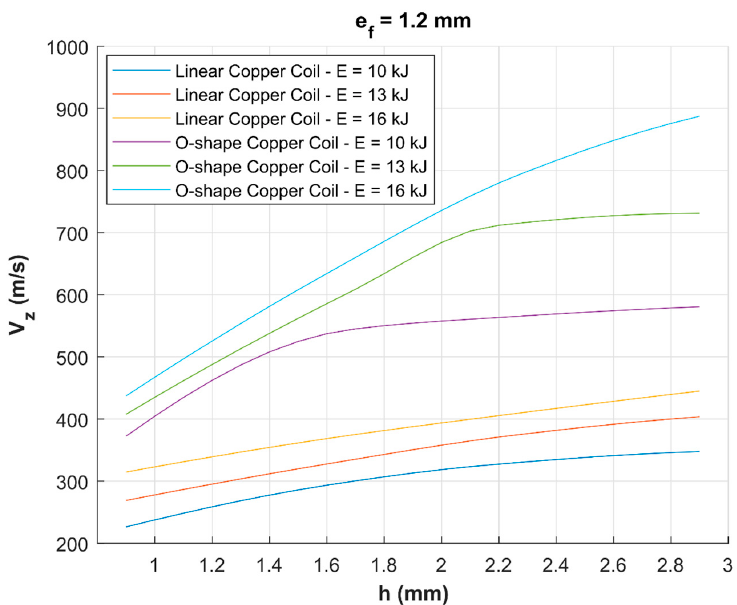
Figure 14. Impact velocity comparison between the OFHC O-shape and linear coils ( e f = 1.2 mm).